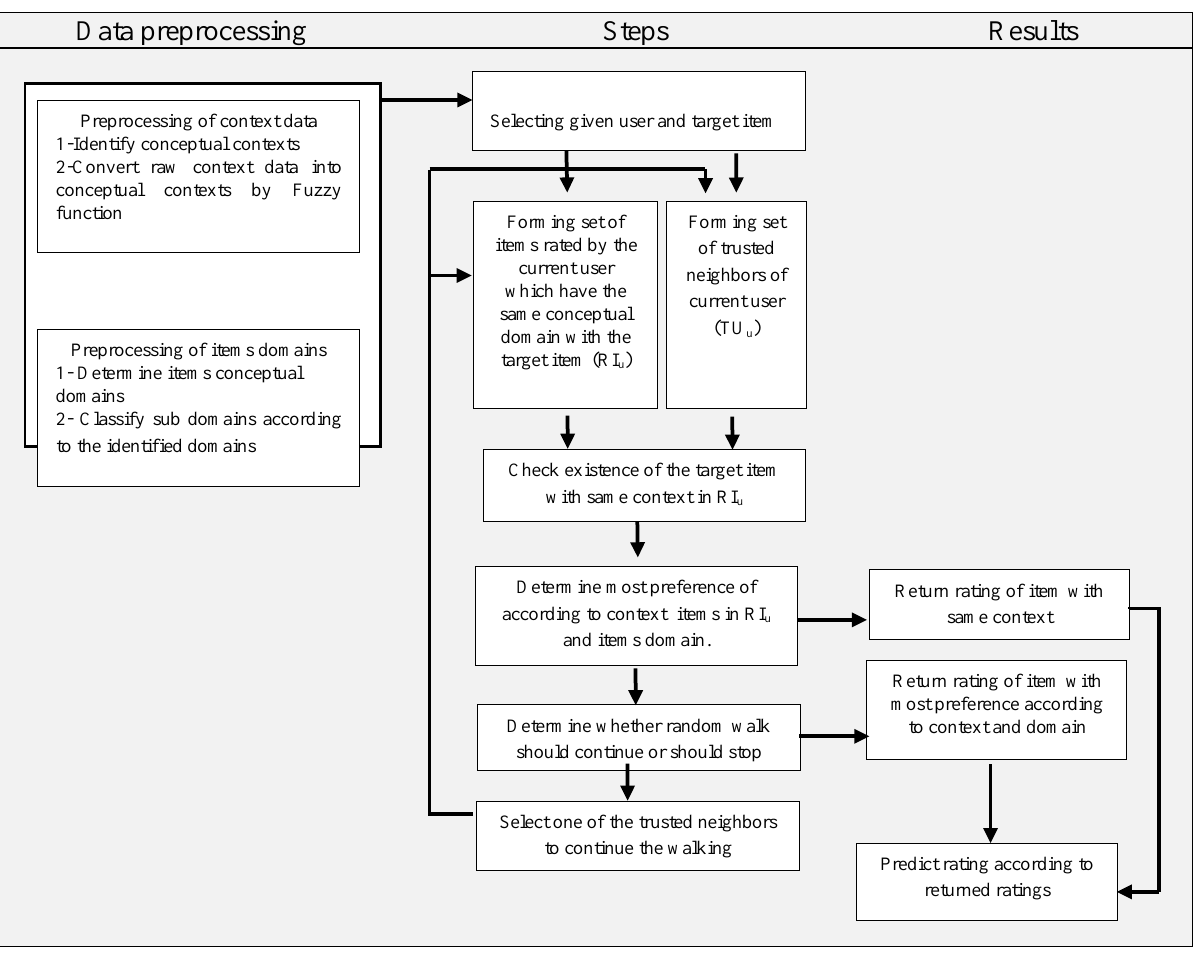
Fig. 1. Steps of Trust-Based Context-Aware